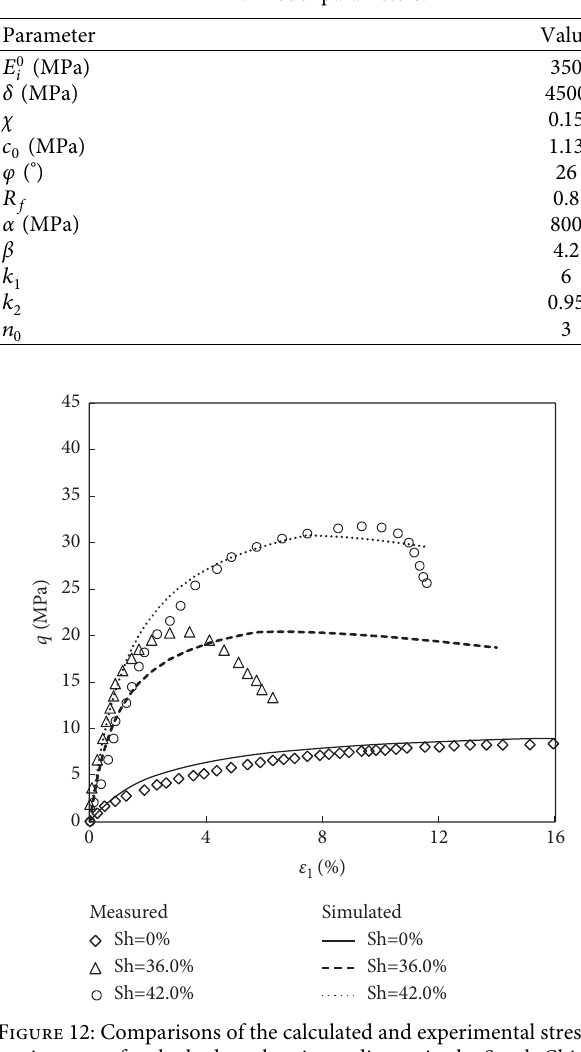
Table 3: Model parameters.